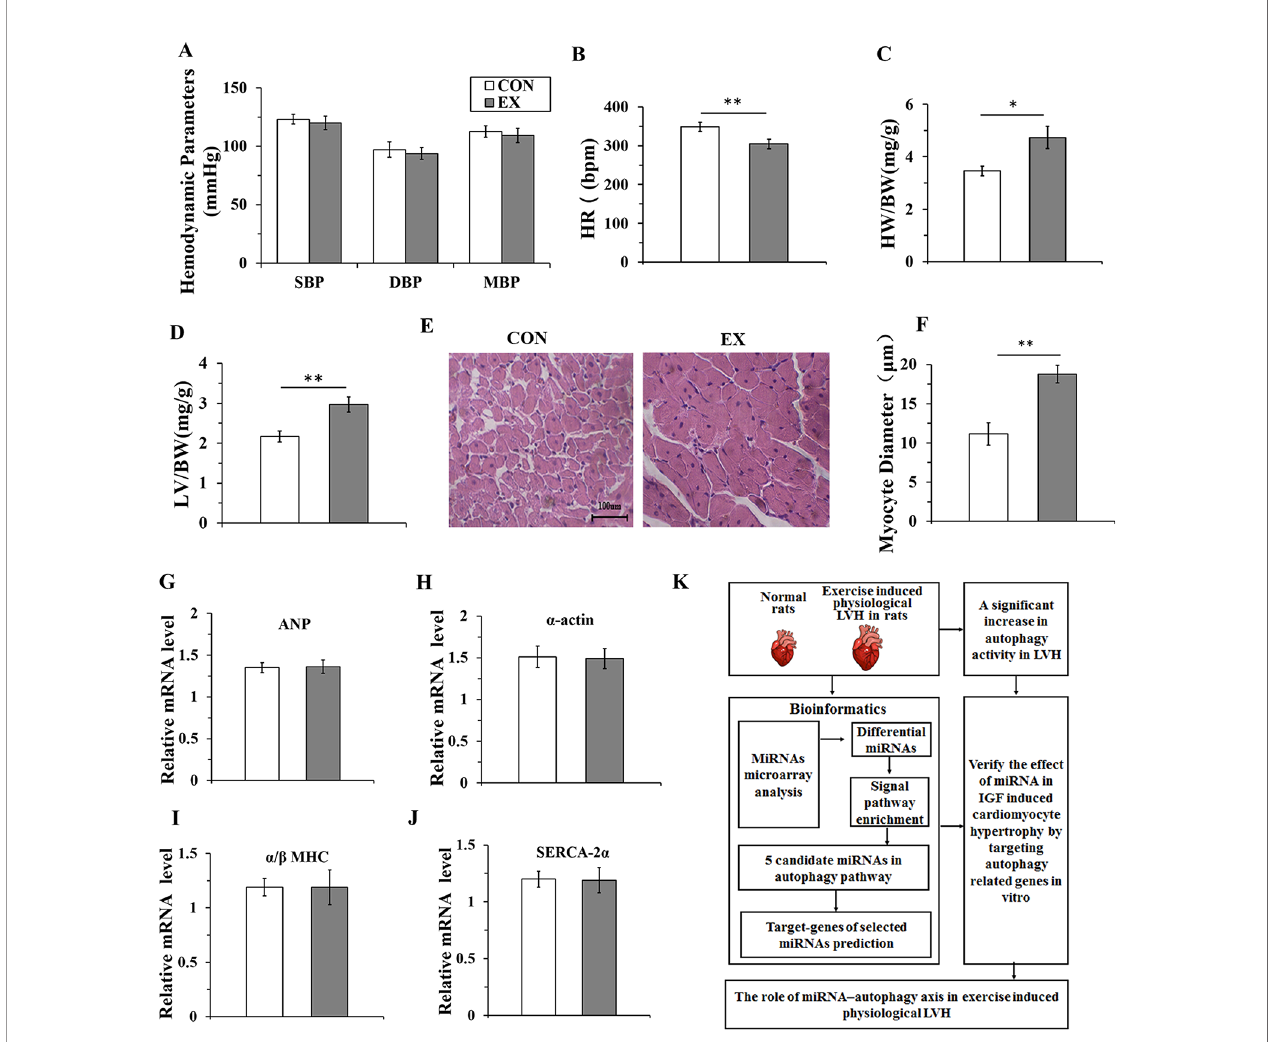
FIGURE 1 | Ten-weeks swimming exercise induces physiological cardiac hypertrophy in rats. (A) , The systolic blood pressure (SBP), diastolic blood pressure (DBP), and mean arterial pressure (MBP) in the control (CON) and swimming exercise (EX) groups. (B) , The heart rate (HR) in the EX group. (C , D) , Ten-week swimming exercise increased the HW/BW and LV/BW ratios in the EX group. BW, body weight; LV, left ventricular weight; HW, heart weight. (E , F) , Hematoxylin staining of LV myocytes in the CON group and EX group. Images were obtained at a magni fi cation of ×400. (G – J) , The levels of atrial natriuretic polypeptide (ANP) and the skeletal muscle a -actin ( a -actin), and the ratio of a / b -myosin heavy chain ( a / b -MHC) and levels of sarco-endoplasmic reticulum Ca 2+ -ATPase (SERCA-2 a ) in the CON group and EX group. (K) , Diagram depicting the experimental process of this study. * P < 0.05, ** P < 0.01, EX group (n=16) vs . CON group (n=16). Data are presented as mean ± SD. Statistical signi fi cance was evaluated with the two-tailed Student's t